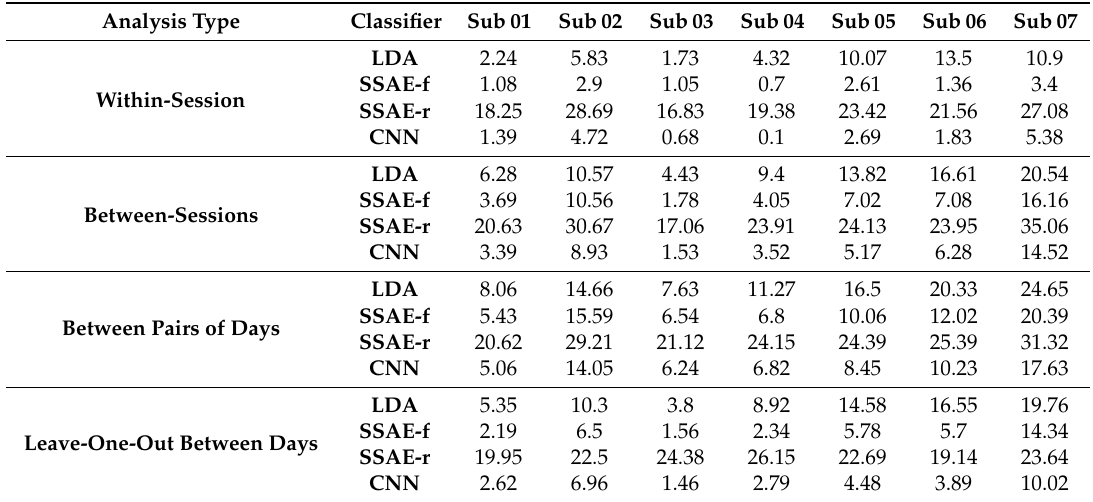
Table 3. Mean classification errors of each subject in all four analyses.